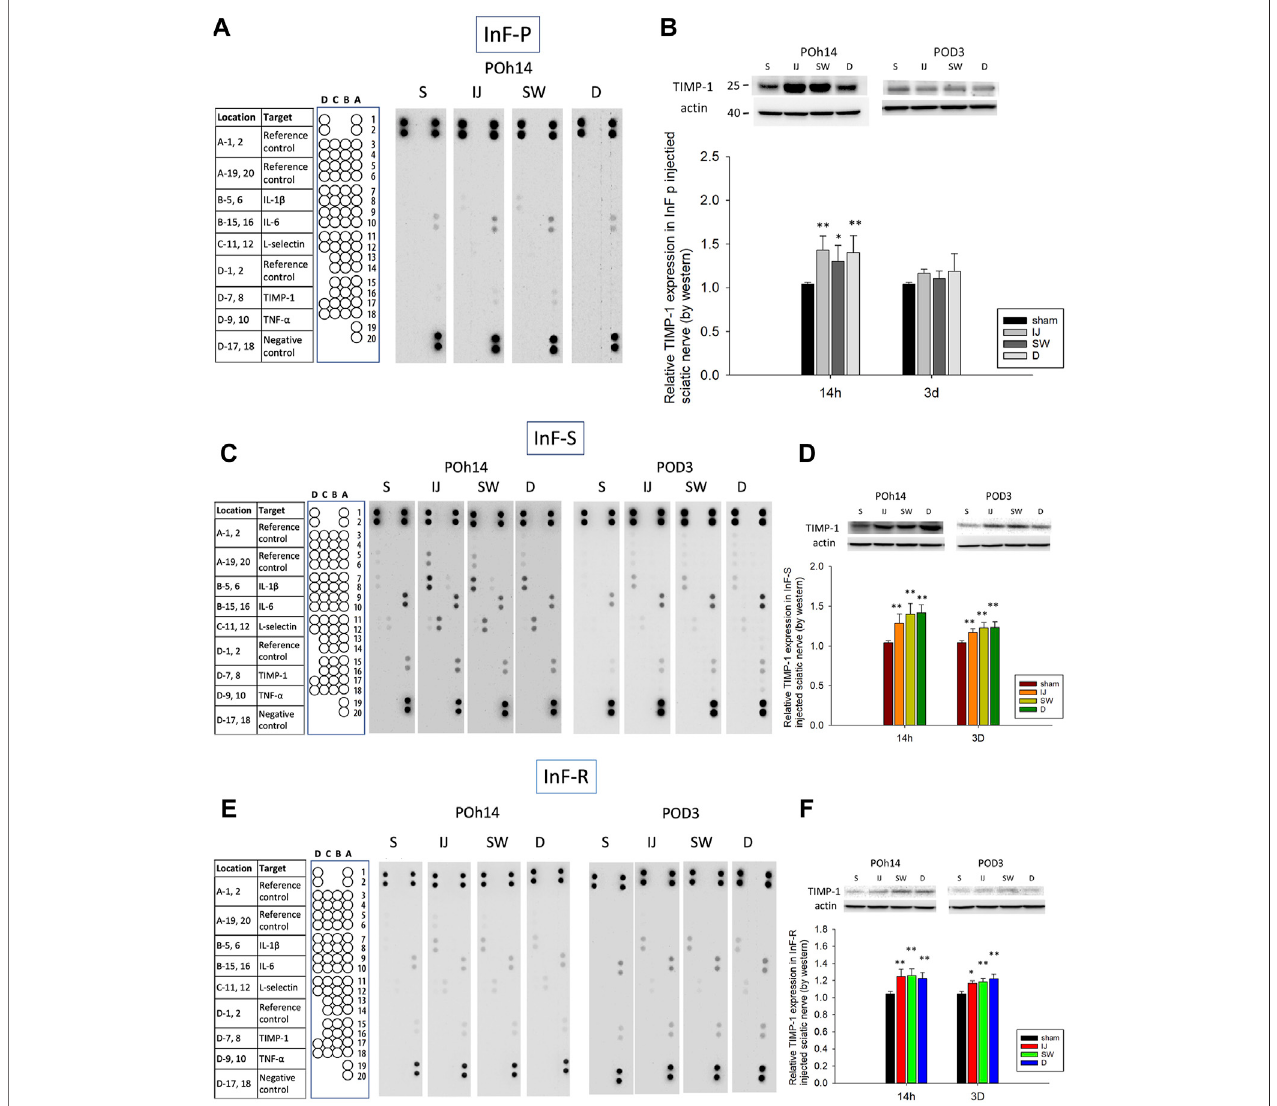
FIGURE 5 | Cytokine expression in three distinct cross-sections of sciatic nerve after intrafascicular injection. Cytokine array was used to measure the expression level of cytokines in sciatic nerve of (A) needle piercing group (InF-P) (C) intrafascicular saline injection group (InF-S) and (E) Intrafascicular ropivacaine injection group (InF-R) at POh14 and POD3. For simple analyte identi fi cation of the location of each cytokine, blank rat cytokine array panel coordinate was indicated on the left side of each array. TIMP-1 protein expression level in sciatic nerve were veri fi ed via Western blotting in (B) needle piercing group (InF-P) (D) intrafascicular saline injection group (InF-S) and (F) Intrafascicular ropivacaine injection group (InF-R) at POh14 and POD3. Double immuno fl uorescence staining of TIMP-1 and (G) migratory macrophage (ED-1) (H) Schwann cell (GFAP) and (I) myelin (MBP) in sciatic nerve swollen site in group InF-S at POD3 were shown. Scale bar: 100 and 75 μ m. POD, post-operation-day; injection site (IJ), swollen site (SW), distal site (D) of sciatic nerve. S: sciatic nerve of sham group, One-way ANOVA. Error bars represent SE. ** p < 0.01, * p < 0.05.,